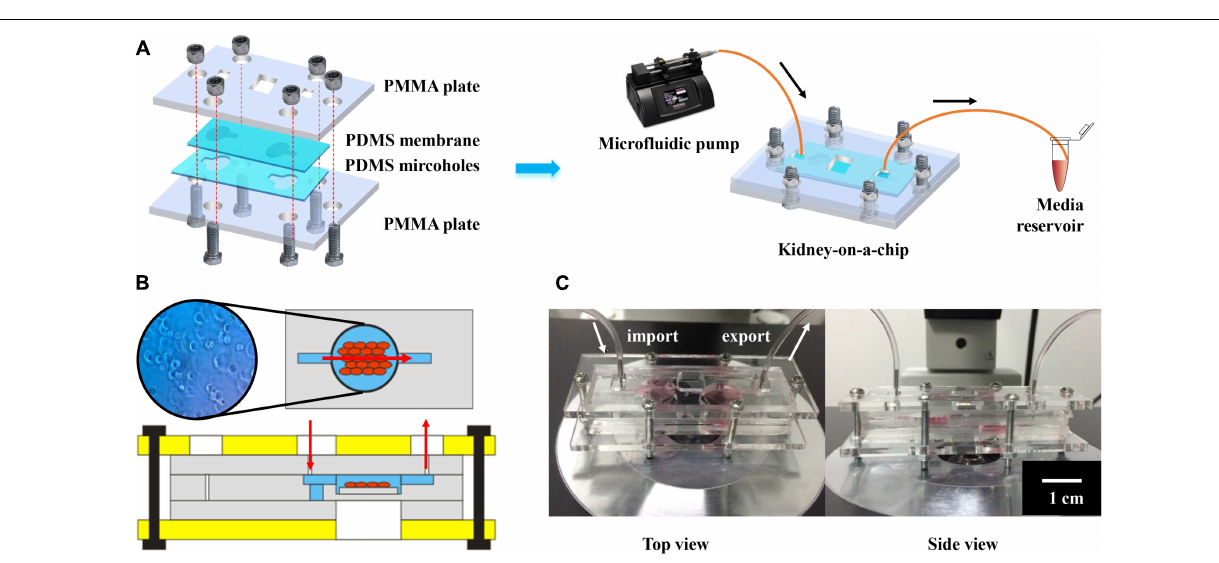
FIGURE 6 | Characterization of kidney-on-a-chip for nephrotoxicity testing: (A) The schematic illustration of the chip, with PDMS membranes for scaffolding, PMMA plates for fixing and continuous medium flow from the microfluidic pump for nutriment exchange. (B) The internal structure and cell conditions of the kidney-on-chip and (C) photographs showing top view and side view of the